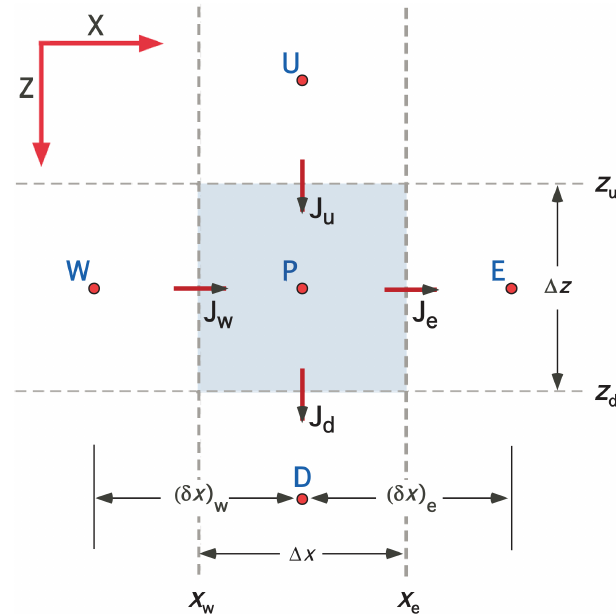
Figure 7. Schematic showing the nomenclature associated with a control volume centered on grid point P for 2-D Cartesian ( XZ ) coordinates. The control volume is bounded by interfaces located at x w , x e , z u , and z d , through which enthalpy fluxes J w , J e , J u , and J d pass. Grid points W, E, U, and D are located at the center of the neighboring control volumes (CVs). The nomenclature for 2-D cylindrical coordinates is completely analogous with R replac- ing X . Three-dimensional (3-D) Cartesian coordinates introduce an additional axis ( Y ) with neighboring grid points S and